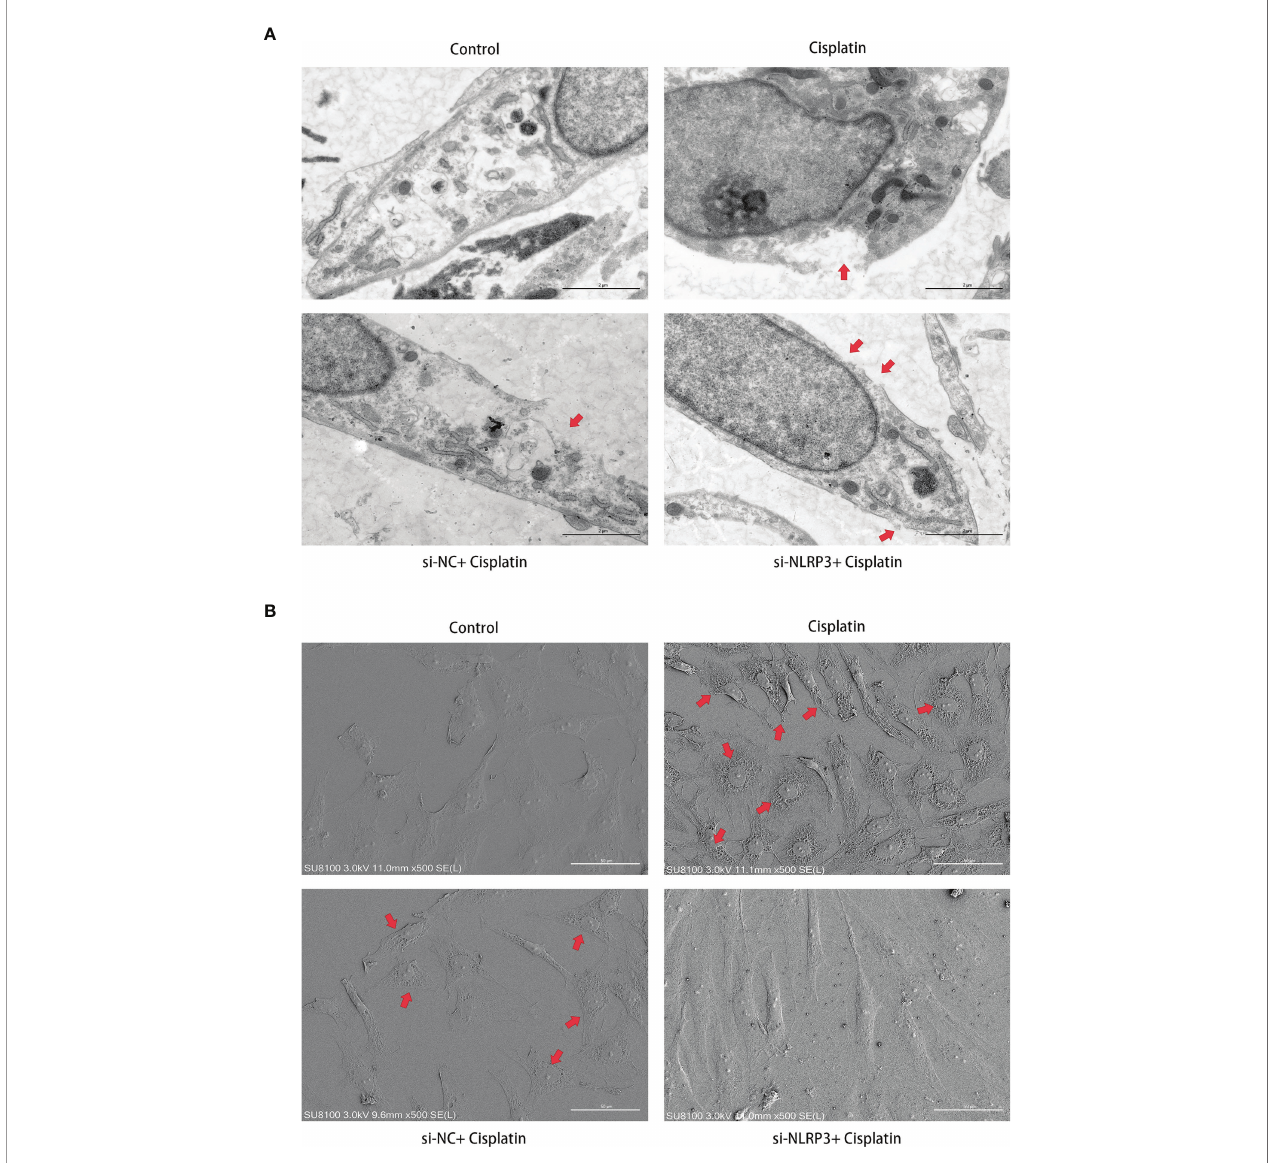
FIGURE 4 | Downregulation of NLRP3 reversed the cisplatin-induced ultramicroscopic changes in MCs. (A) The morphologic changes of MCs after different treatments under TEM. The red arrows indicate the ruptured cell membrane and local lighter-stained cytoplasm. Scale bars: 2 µm. (B) The morphological changes of MCs observed by SEM. The red arrows indicate the withered tree-like cell membrane at the edge of the cell. Scale bars: 50 µm. Representative results of at least three repeated experiments are